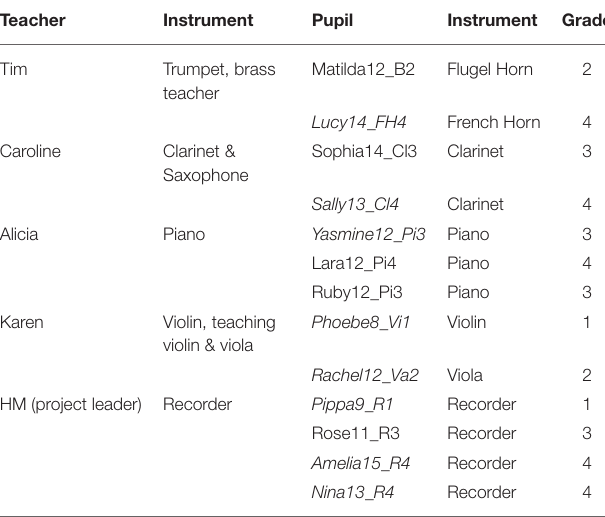
TABLE 1 | Participants’ codes and